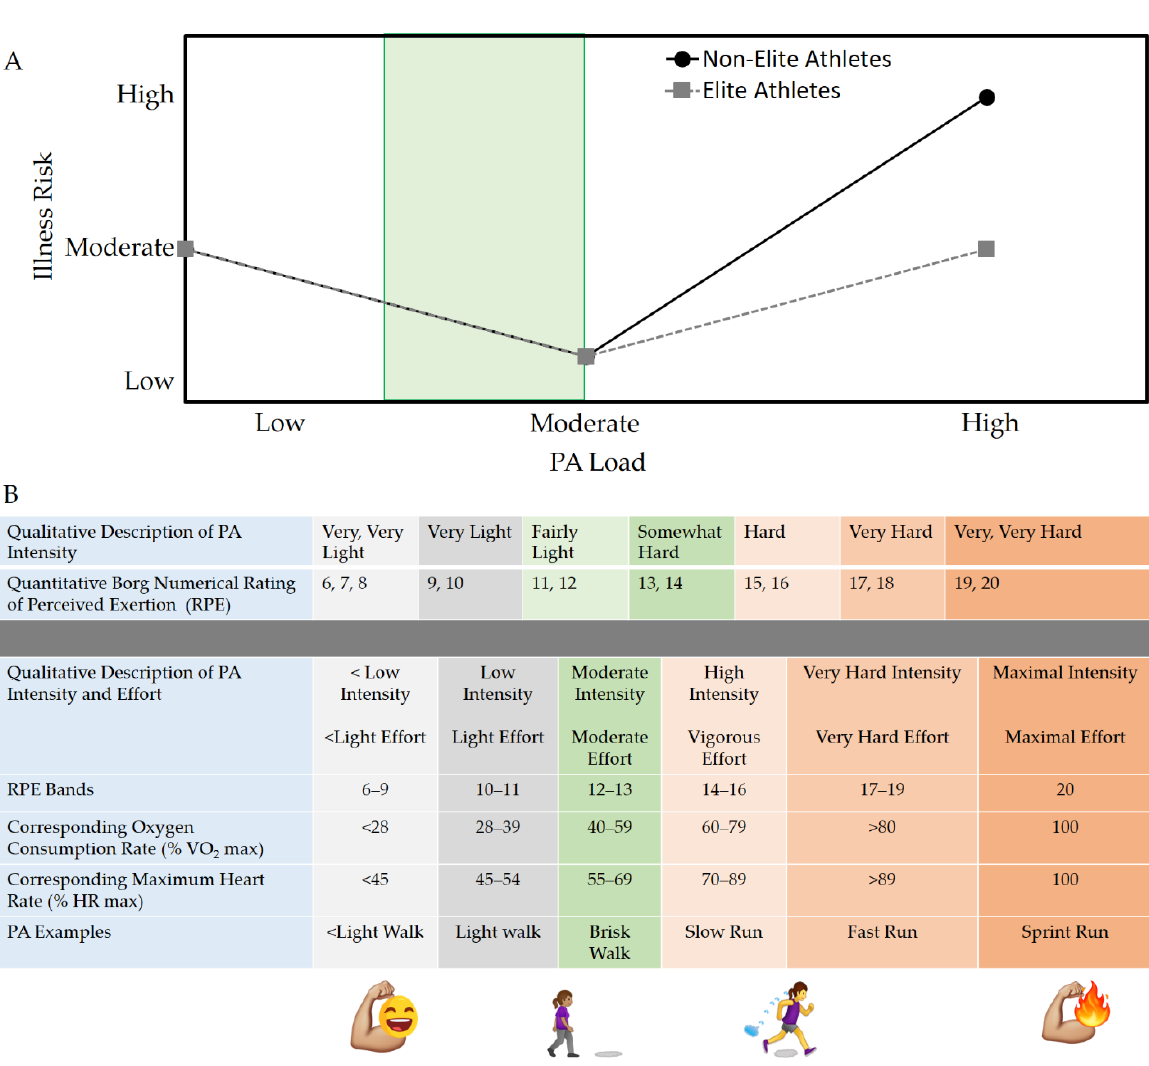
Figure 2. “Just Right” PA and reduction in overall illness risk. ( A ) Since there is a link between PA load (the combination of activity intensity and duration) and illness risk, it is important not to perform high loads of unaccustomed PA during the COVID-19 pandemic [57]. For the majority of women in the population whose physical ability level is not at the level of elite athletes, moderate PA is likely to be beneficial while unaccustomed, intense PA is likely to be harmful. Each individual should gauge for themselves, under the advice of suitable healthcare professionals, what their “just right” level of PA is (Green Zone in figure). For elite athletes, while setting PA load, the risk of illness must be weighed against the benefit of being able to return to a competitive level when COVID-19 restrictions are lifted. Furthermore, healthy elite athletes who are accustomed to high PA loads as part of systematic training have a lower risk of illness even with high PA loads. ( B ) Since the self-reported rating of perceived exertion (RPE) correlates well with VO 2 max and HR, RPE is a simple yet reliable tool for gauging the intensity of PA and for adjusting PA load as needed [58,59].